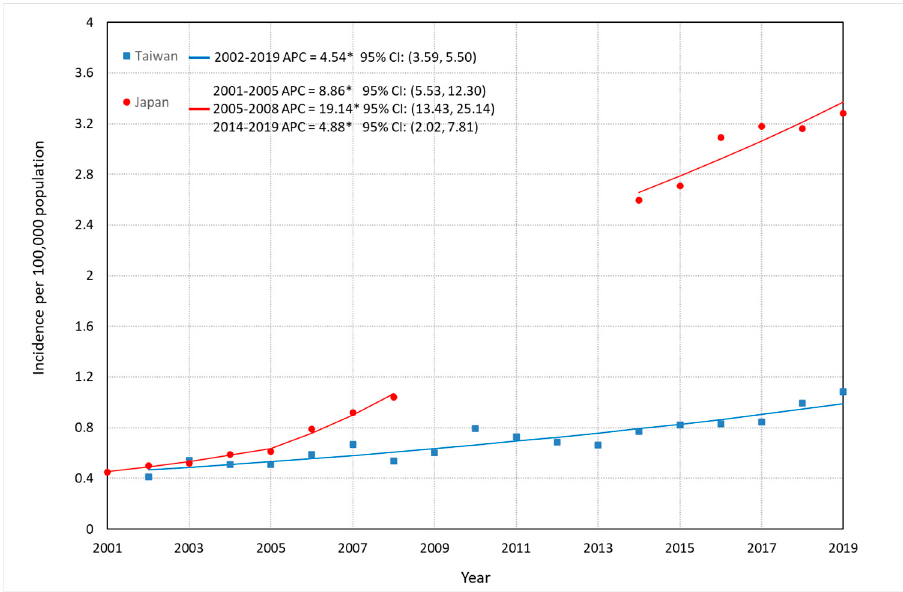
Figure 3. Trends in the ASRs of FL for females in Taiwan and Japan. * The APC is significantly different from 0 at the alpha level of 0.05.